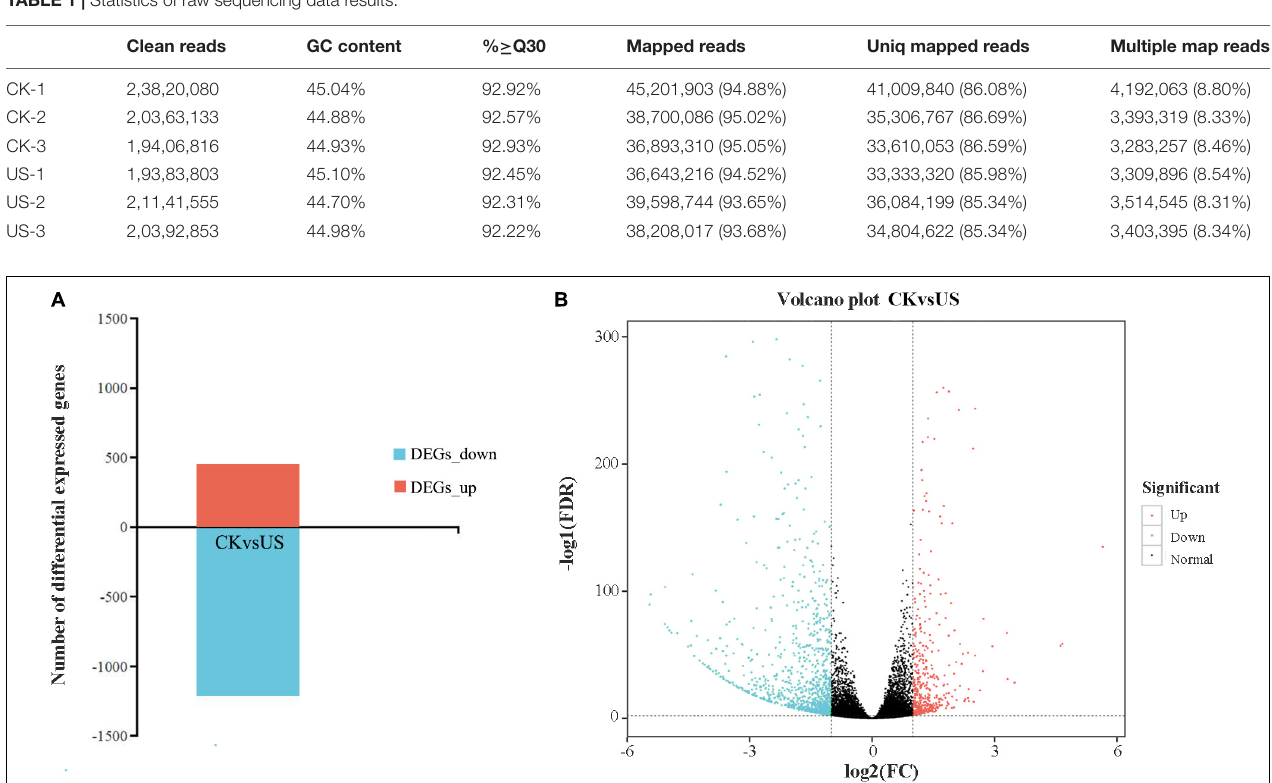
FIGURE 4 | Summary of differentially expressed genes (DEGs) and volcano plot analysis. (A) DEGs. (B) Volcano plot analysis. Red color indicates upregulated genes. Blue color indicates downregulated genes.